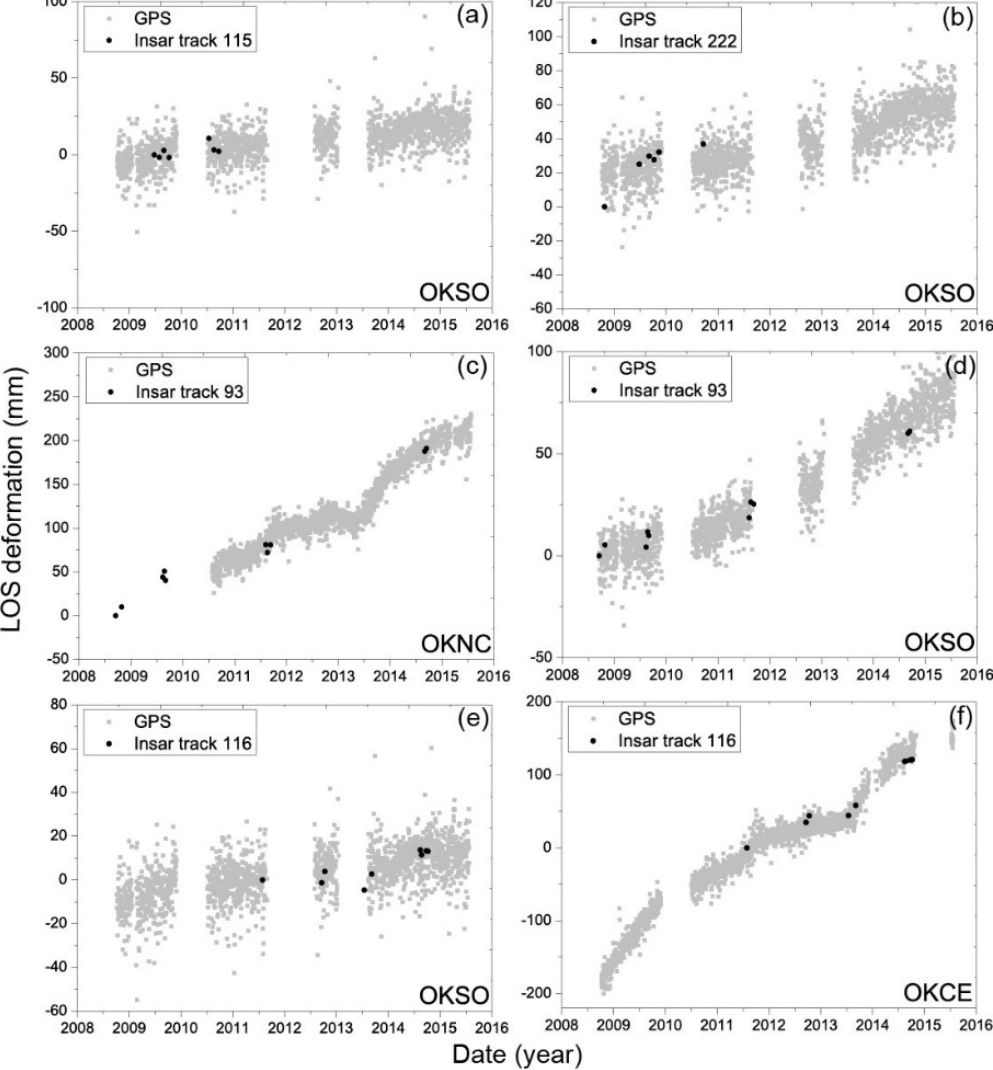
Figure 7. Comparison of InSAR-derived LOS deformation with that from GPS: ( a ) deformation from Envisat track 115 and GPS at station OKSO, ( b ) deformation from Envisat track 222 and GPS at station OKSO, ( c ) deformation from TerraSAR-X track 93 and GPS at station OKNC, ( d ) deformation from TerraSAR-X track 93 and GPS at station OKSO, ( e ) deformation from TerraSAR-X track 116 and GPS at station OKSO, ( f ) deformation from TerraSAR-X track 116 and GPS at station OKCE. GPS station locations are shown in Figure 1, and all the GPS measurements are reference to OKFG.